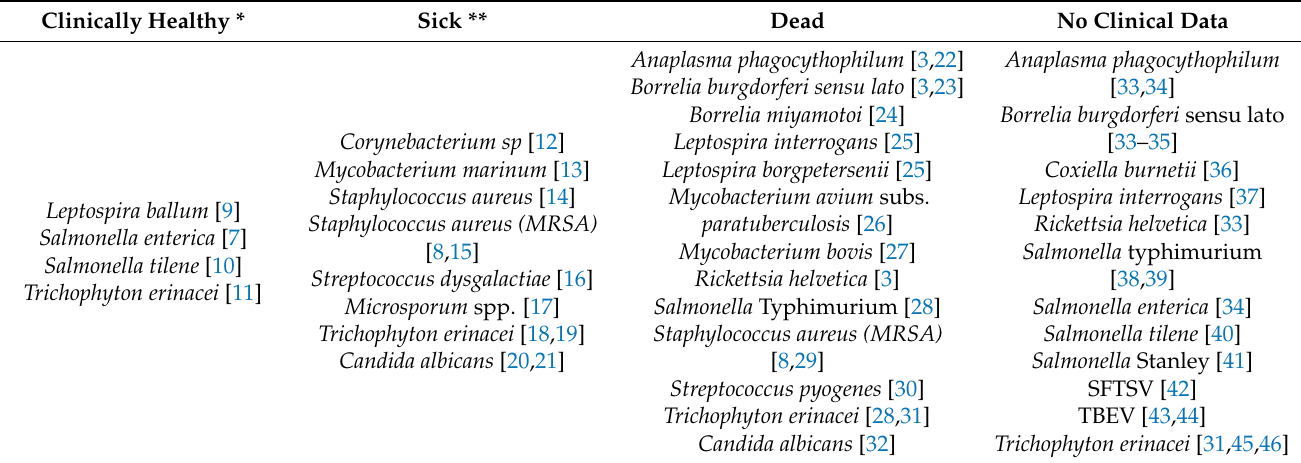
* Clinically healthy: animals with no clinical signs of disease, ** Sick: animals displaying clinical signs of infection.